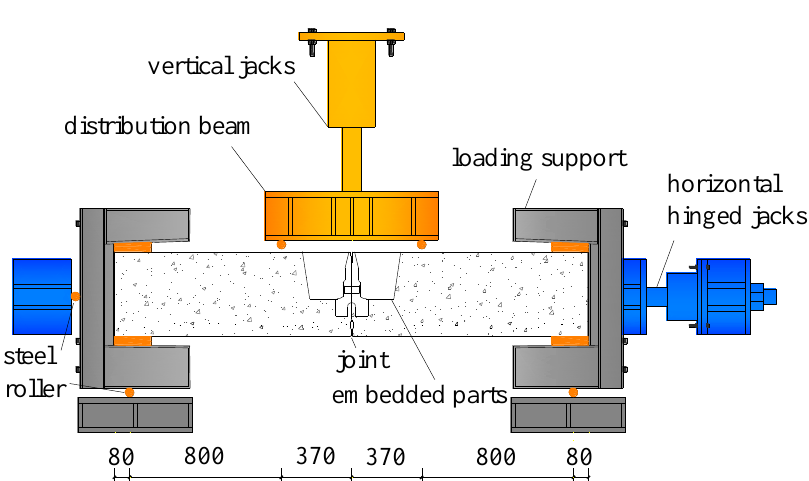
Figure A1. View of specimen and loading device for bending moment resistance experiment.